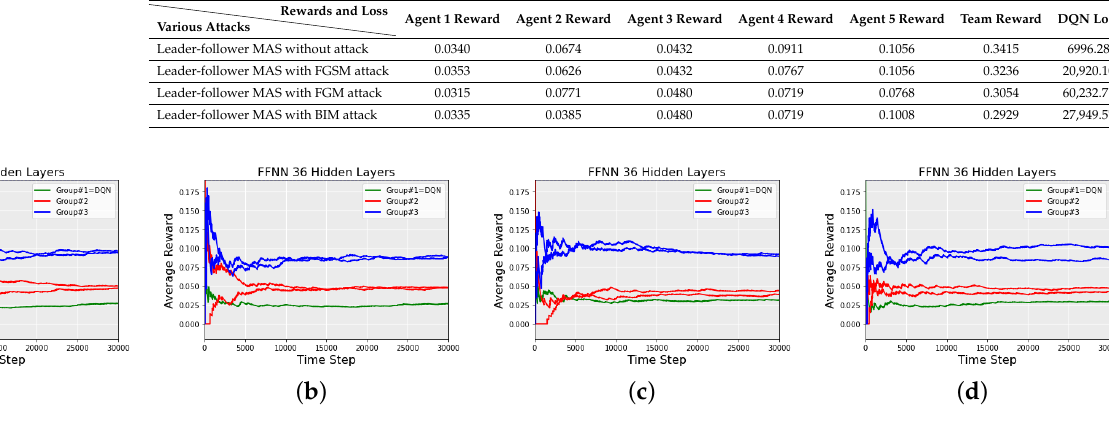
Figure 9. Reward convergence of a heterogeneous leader-follower MAS, including N = 5 agents in P = 3 different clusters, during 30,000 time steps by considering time-delay and distance-based reward under FGSM, FGM, and BIM adversarial attacks. ( a ) Average reward of a leader-follower MAS without adversarial attack. ( b ) Average reward of a leader-follower MAS under FGSM adversarial attack. ( c ) Average reward of a leader-follower MAS under FGM adversarial attack. ( d ) Average reward of a leader-follower MAS under BIM adversarial attack.